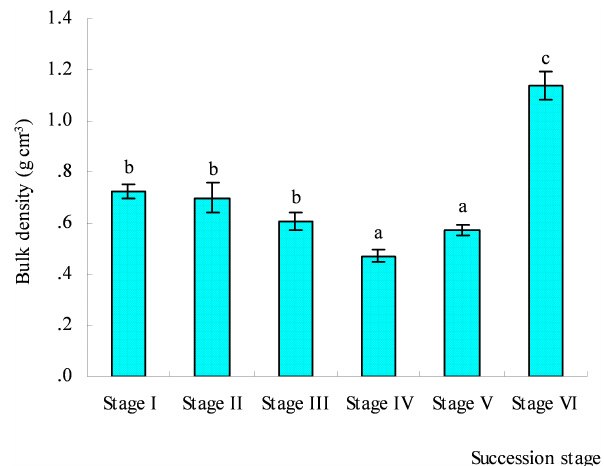
Figure 6. Surface soil-bulk density over the course of succession. The values represent the means ± 1SD of four replicates. Differ- ent letters in the figures indicate significant differences between stages at P <0.05. The stage details refer to Fig. 2.